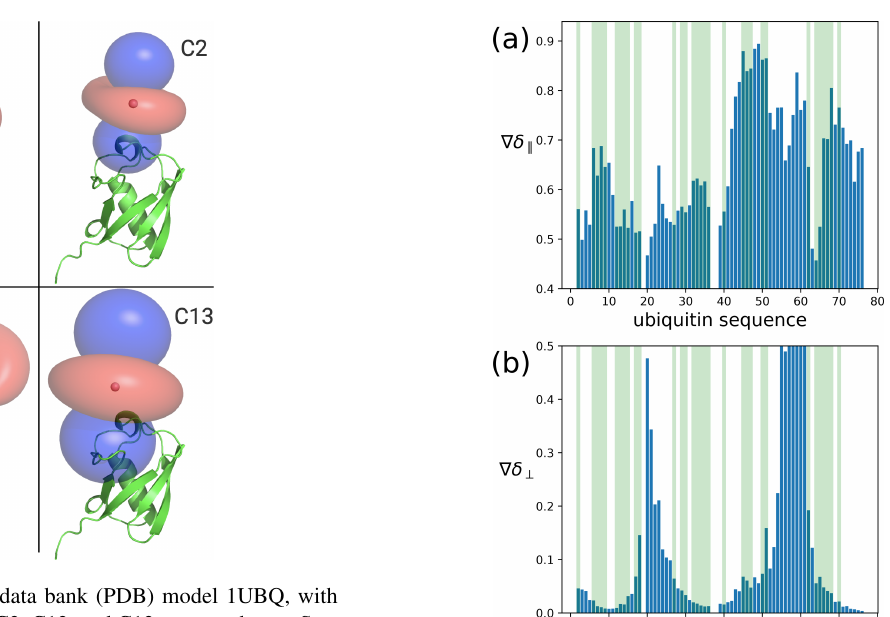
Figure 6. Ubiquitin protein data bank (PDB) model 1UBQ, with PCS isosurface plots for C1, C2, C12, and C13 tags, as shown. Sur- faces shown in blue and red represent a constant PCS value of + 1.0 and − 1.0ppm, respectively. Each panel displays the protein struc- ture in the same orientation.